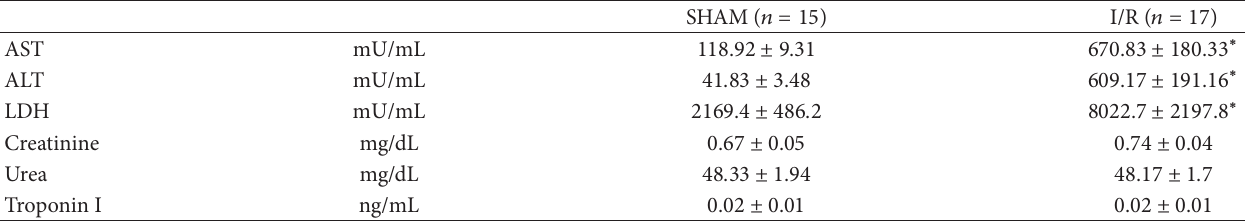
Table 1: Serum levels of AST, ALT, LDH, creatinine, urea, and Troponin I in animals submitted to ischemia/reperfusion (I/R). Sham-operated group (control) has been compared with I/R group: ∗ 𝑃 < 0.05 . These are the mean results of 32 different experiments ± S.E.M.